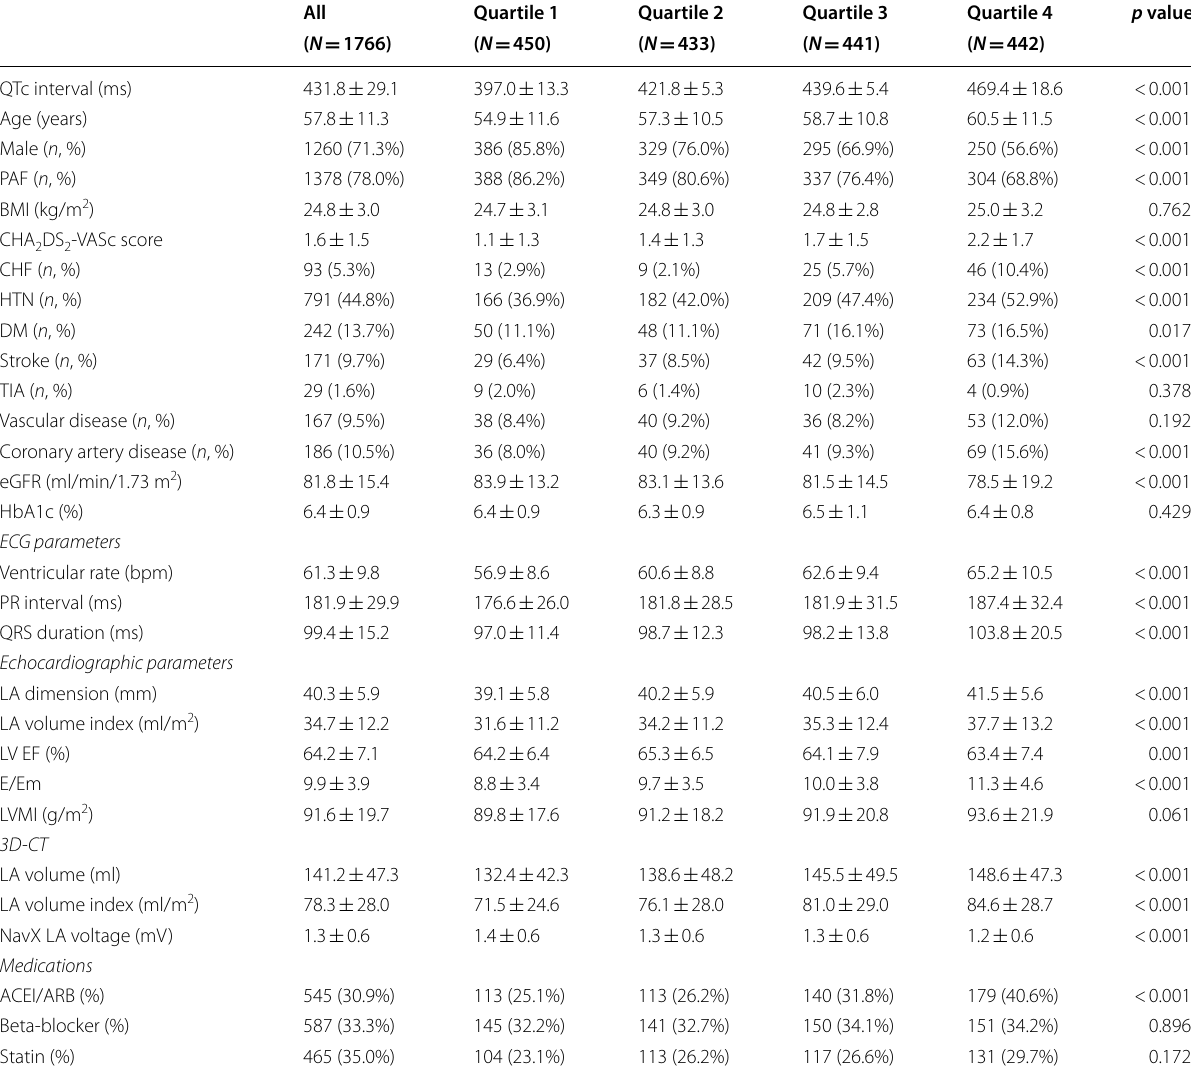
ACEI/ARB, angiotensin-converting enzyme inhibitors/angiotensin-receptor blockers; BMI, body mass index; CHF, congestive heart failure; DM, diabetes mellitus; ECG, electrocardiogram; E/Em, ratio of early diastolic transmitral flow velocity and mitral annular velocity; eGFR, estimated glomerular filtration rate; HbA1c, hemoglobin A1C; HTN, hypertension; LA, left atrial; LV EF, left ventricular ejection fraction; LVMI, left ventricular mass index; PAF, paroxysmal atrial fibrillation; TIA, transient ischemic